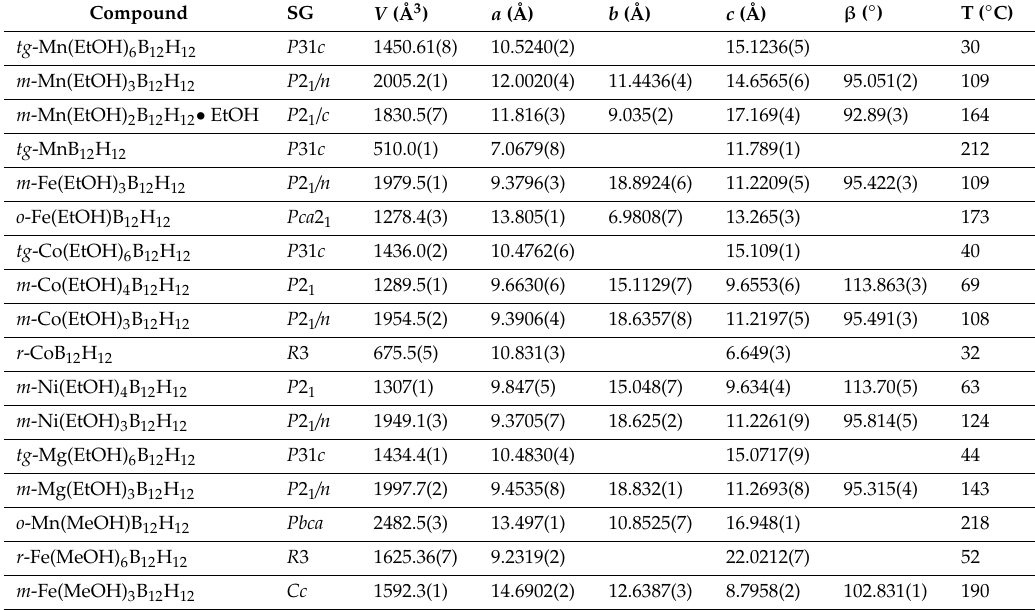
Figure 5. Stability of crystalline compounds observed in metal-EtOH and metal-MeOH samples determined from in-situ X-ray powder diffraction under dynamic vacuum. The phase composition at room temperature (RT) on the left side of the temperature scale corresponds to the as prepared samples. The temperatures of the stability limits in closed system are labelled with c.s. Table 1. Space group (SG) symmetry, lattice parameters determined at temperature T. The meaning of the prefixes in the compound name are tg- for trigonal, m- for monoclinic, o- for orthorhombic, r- for rhombohedral.